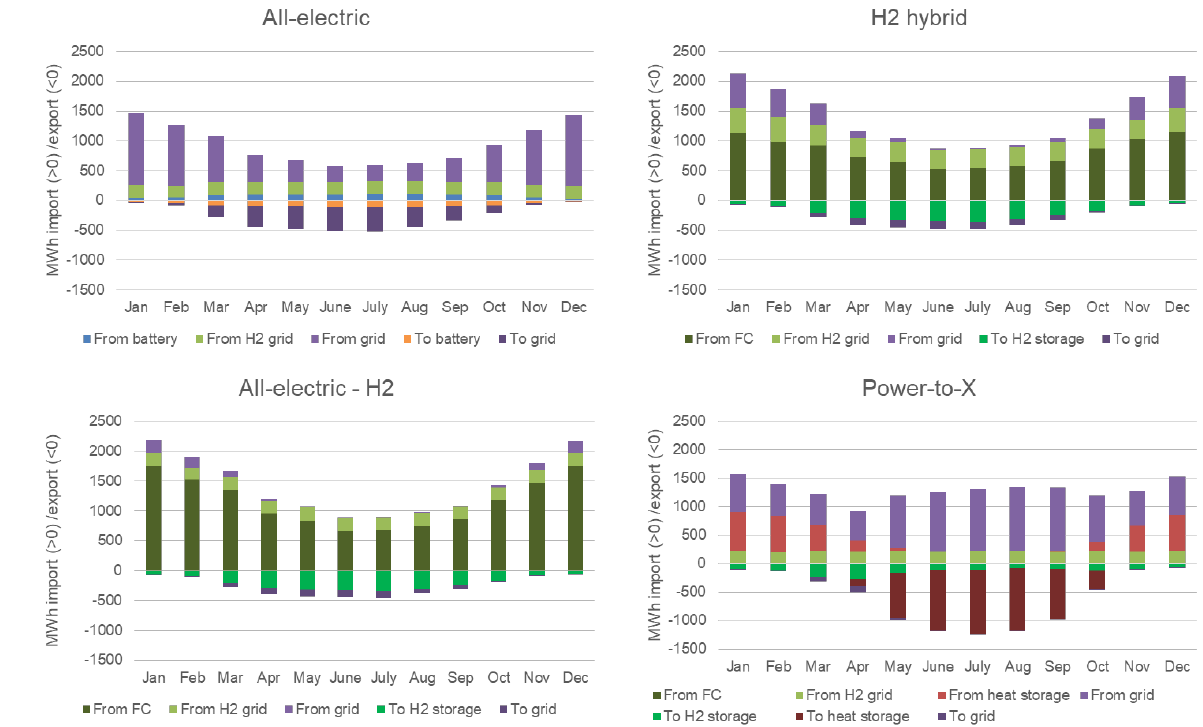
Figure 11. Monthly energy balance of the four scenarios, positive values represent energy use, while negative values show the energy that is stored or exported. The all-electric scenario has the lowest overall energy demand because it has the least conversion losses. The all-electric, all-electric H 2 and H 2 hybrid systems all show a seasonal pattern of lower energy demand and more export in summer, and higher energy demand and less export in winter. The power-to-X scenario has a more distributed energy demand pattern, as in summer, heat is produced with the large-scale heat pump (with surface water as a source), and heat is stored for use in winter.